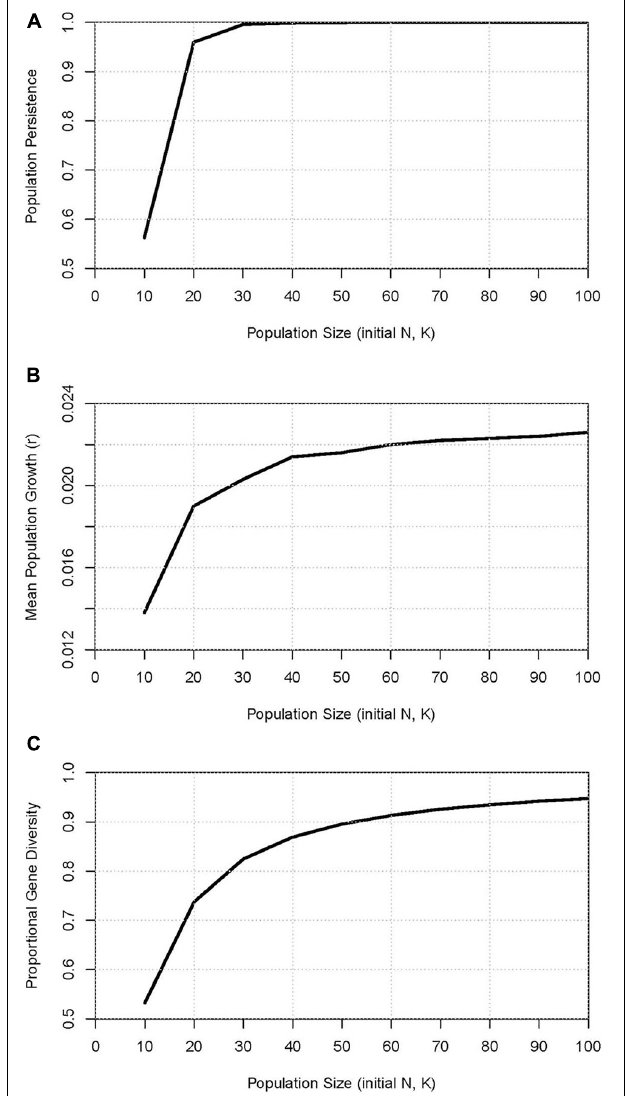
FIGURE 5 | Measures of viability over 100 years in extant simulated populations that are closed to immigration with starting size (N) and carrying capacity (K) varied from 10 to 100: (A) probability of population persistence, (B) projected mean population size, and (C) proportion of gene diversity retained.